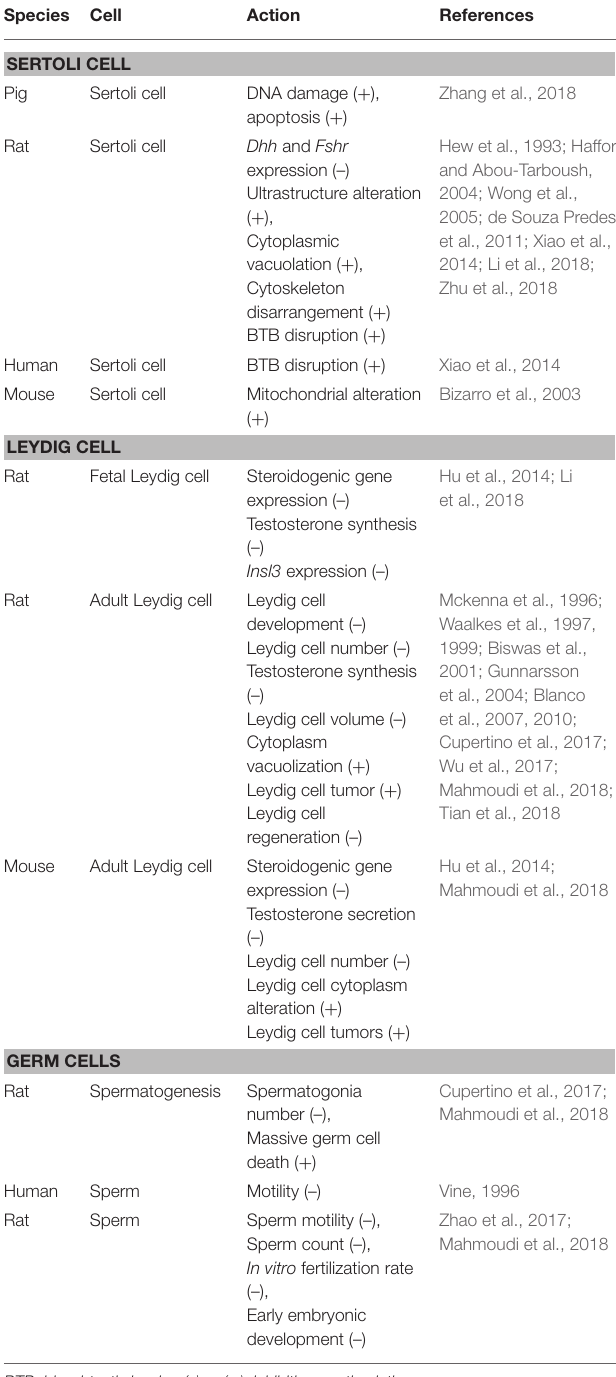
TABLE 1 | Action of cadmium on testicular